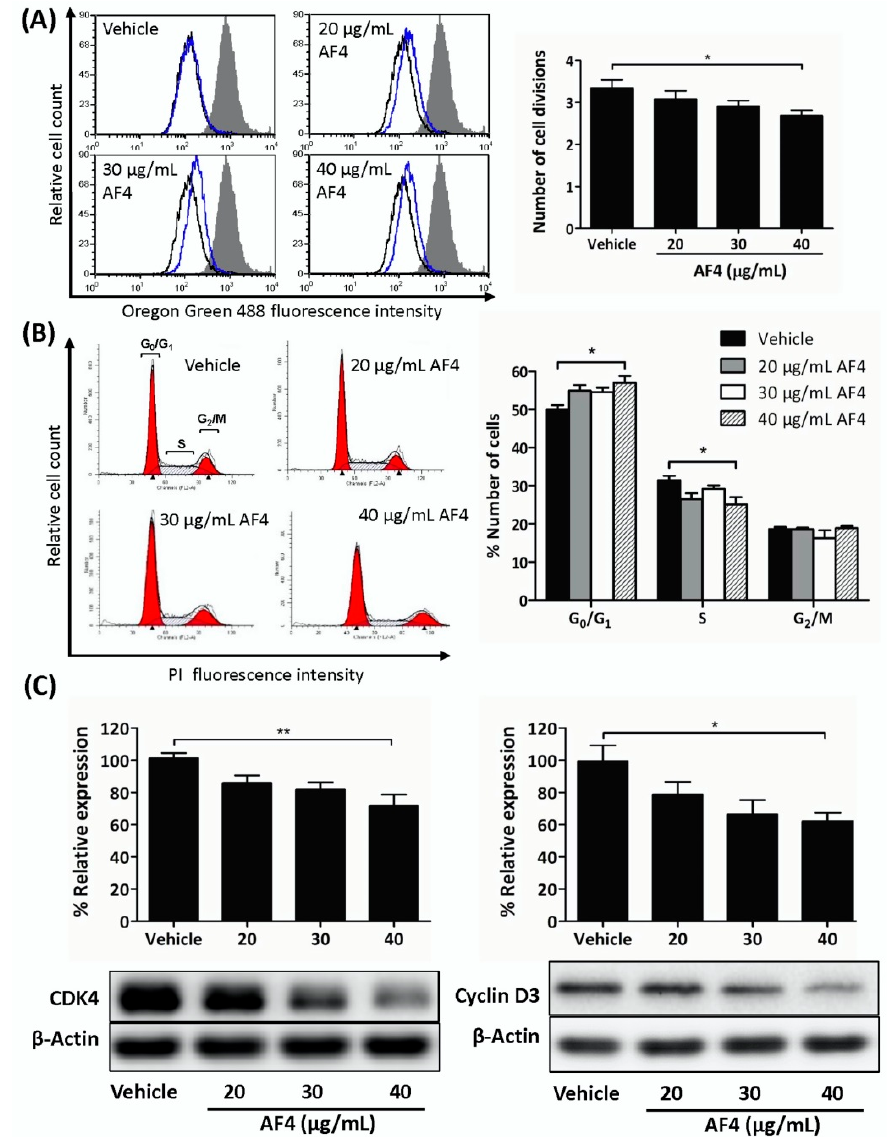
Figure 2. AF4 inhibits breast cancer cell proliferation. ( A ) MDA-MB-231 cells were stained with Oregon Green 488 dye and then cultured for 72 h in the absence or presence of the indicated concentrations of AF4. Fluorescence was measured by flow cytometry. Data are shown as representative histograms (filled peak, non-proliferating cells; black peak, vehicle; blue peak, AF4) and mean number of cell divisions ± SEM. ( B ) MDA-MB-231 cells were cultured for 72 h in the absence or presence of the indicated concentrations of AF4. Cells were stained with propidium iodide (PI) and cell cycle analysis was performed by flow cytometry. Data are shown as representative histograms and mean % number of cells ± SEM in each phase of the cell cycle. ( C ) MDA-MB-231 cells were cultured for 24 h in the absence or presence of the indicated concentrations of AF4. The relative expression of CDK4 and cyclin D3 was determined using Western blot analysis. Equal protein loading was confirmed by probing for β -actin. Data shown are representative blots and mean % relative expression ± SEM. (A–C) Statistical analysis of 3 independent experiments was performed using ANOVA and Tukey’s multiple comparisons test; * p < 0.05, ** p <